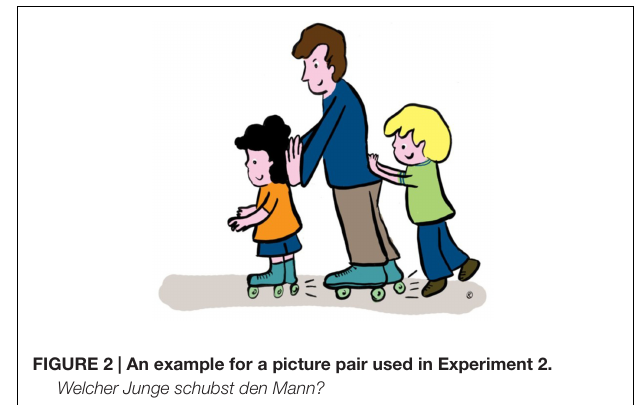
FIGURE 2 | An example for a picture pair used in Experiment 2. Welcher Junge schubst den Mann? Which NOM , MASC boy pushes the ACC , MASC man? ‘Which boy is pushing the man?’